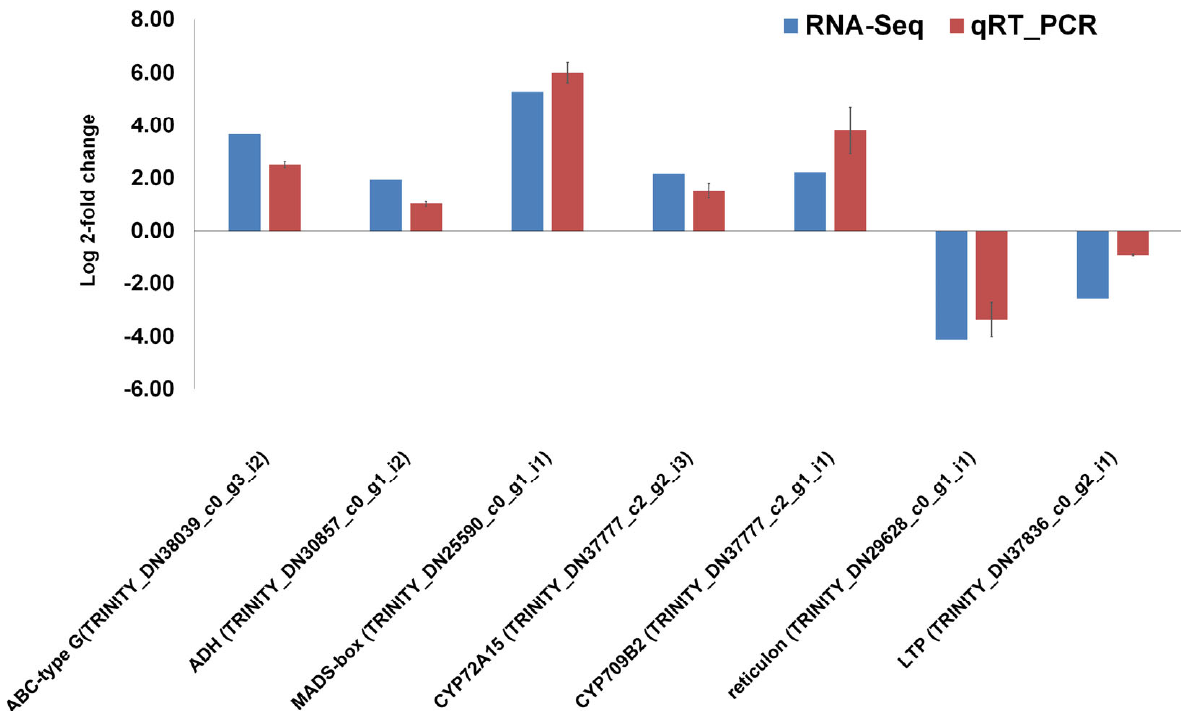
Figure 8. Validation of RNA ‐ seq results using qRT ‐ PCR. The fold changes of seven selected DEGs quantified using RNA ‐ seq and qRT ‐ PCR were shown. The blue bars represent RNA ‐ seq results, and the red bars represent qRT ‐ PCR results.